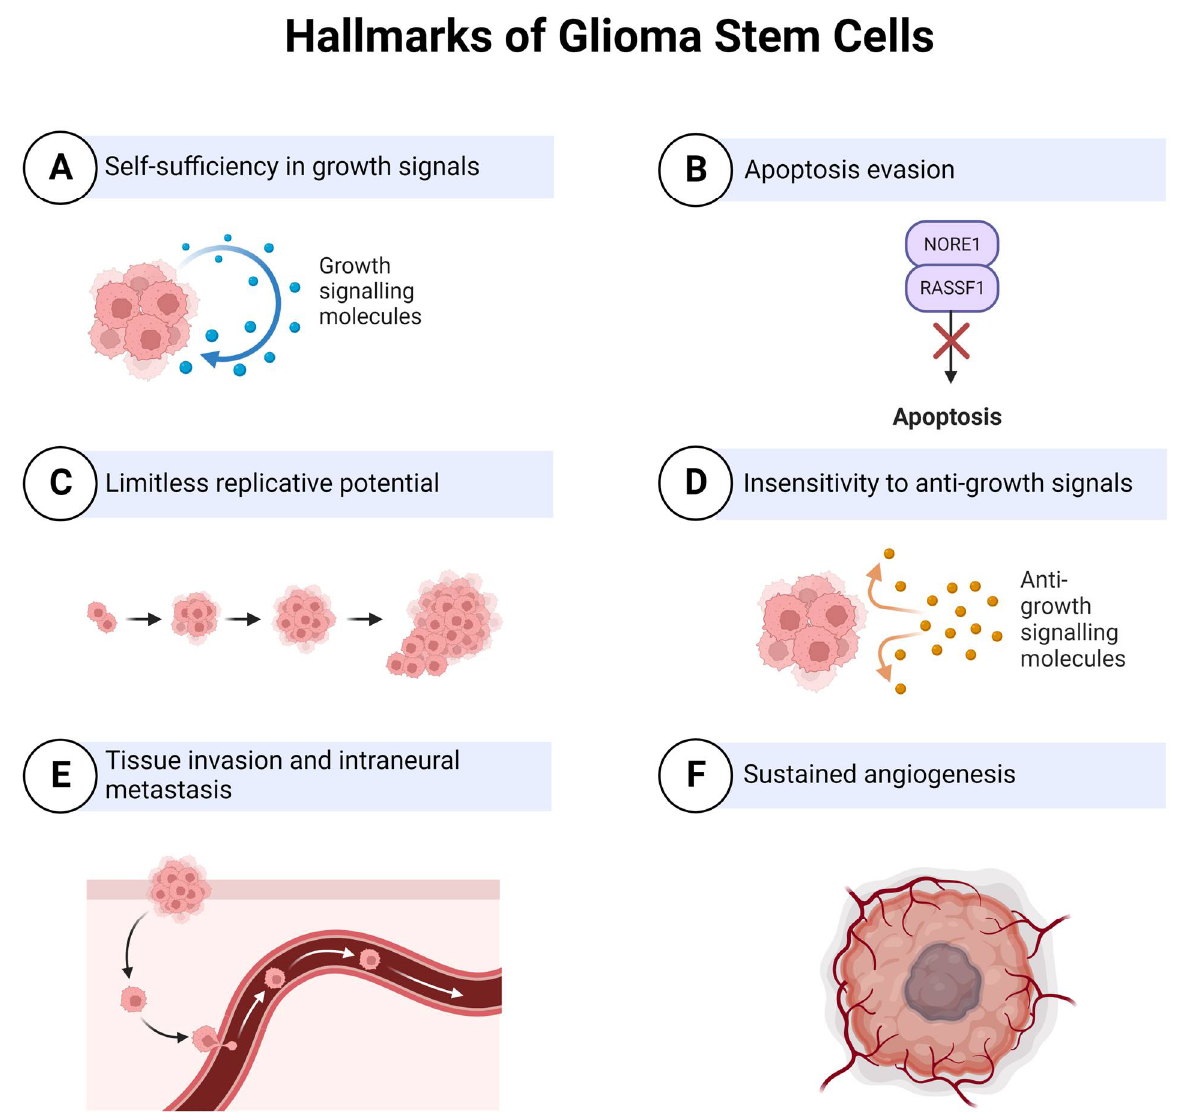
Figure 3. Hallmarks of Glioma Stem Cells (GSCs). GSCs are the primary contributors to the aggressive nature of glioblastoma. The features that make these cells particularly invasive are self-sustained growth signalling, evasion of programmed cell death, limitless replicative potential with minimal cell senescence, tissue invasion and intraneural metastasis and sustained angiogenesis/increased vascularisation. Adapted from Biorender.com accessed on 1 October 2022.